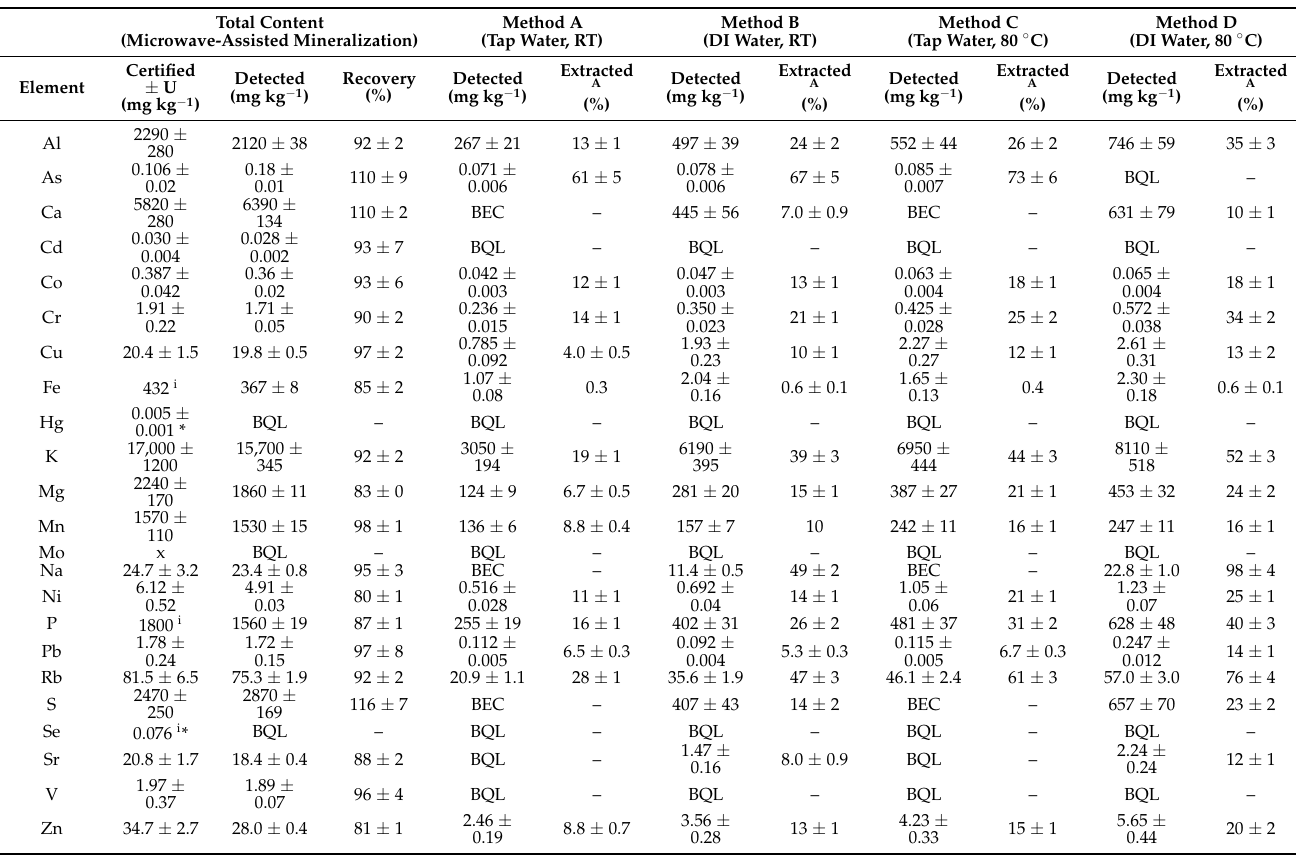
Table 4. ICP OES analysis of tea leaves (INCT–TL–1), prepared using microwave-assisted miner- alization (total content), and four procedures of ultrasound-assisted extraction (A–D). All results presented as mean ± SD (n = 3), except where